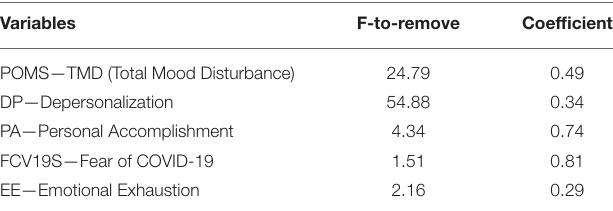
TABLE 4 | Results of discriminant analysis (Wilks’ 3 = 0.67, χ 2 = 20.05, p <